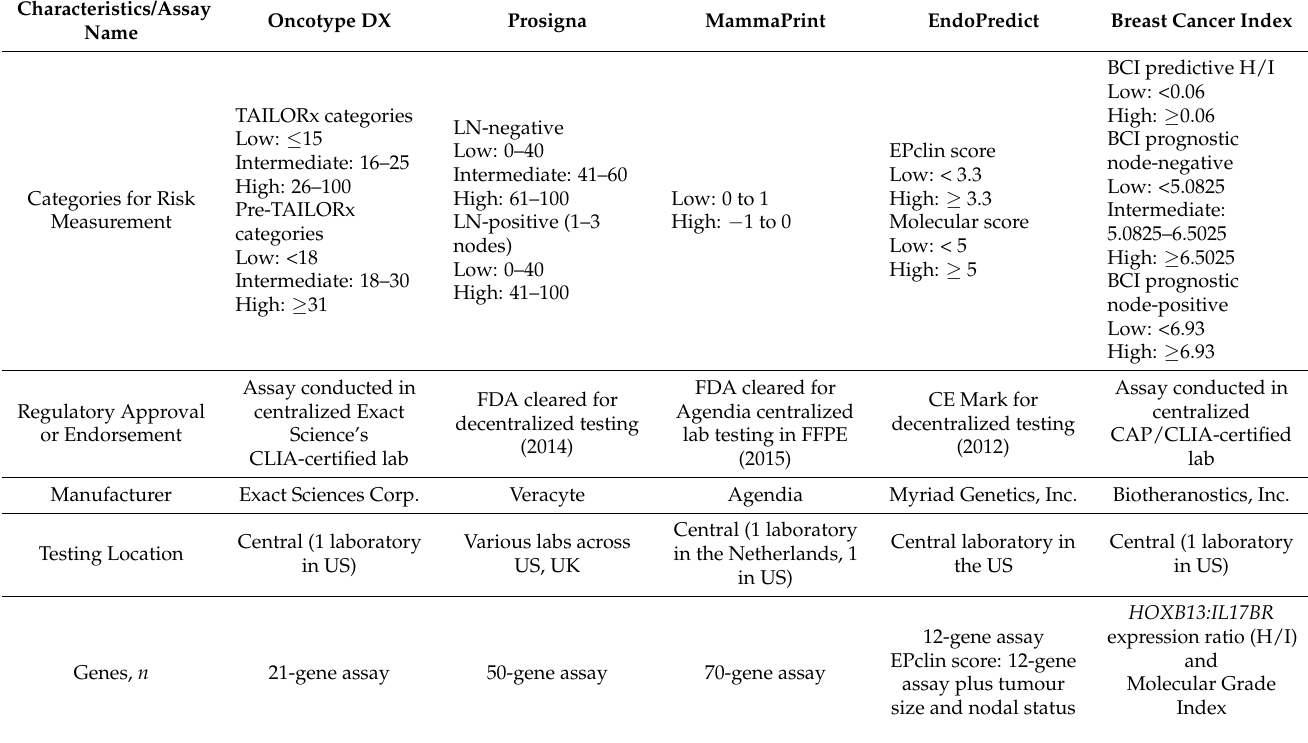
ER-positive, HER2-negative early-stage breast cancer that is under consideration for adjuvant chemotherapy